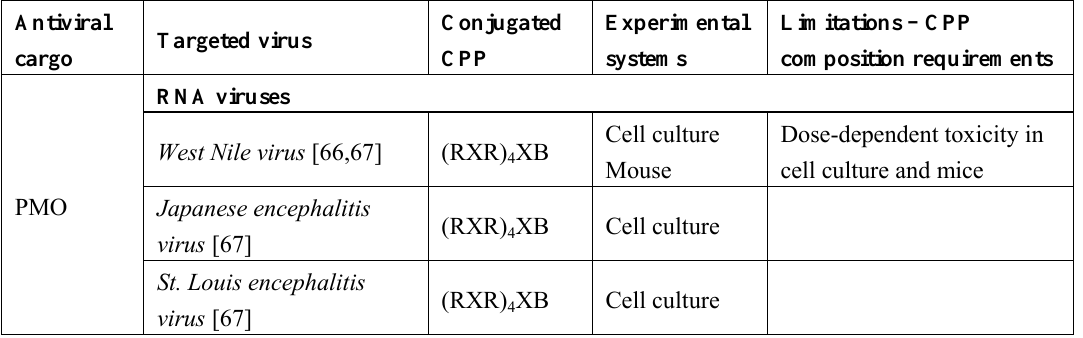
Table 1. Antiviral agents successfully delivered into virus-infected cells via conjugation to CPPs. CPPs from conjugates which exhibited some antiviral activity are mentioned. R stands for arginine, X for 6-aminohexanoic acid, and B for β